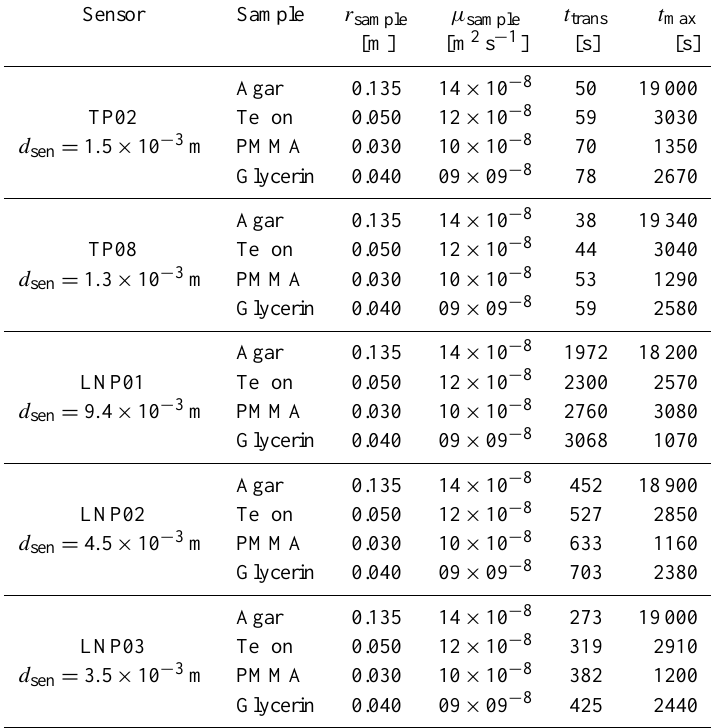
Table 1. Maximum and minimum measurement times estimated for the different sensors when used in various calibration